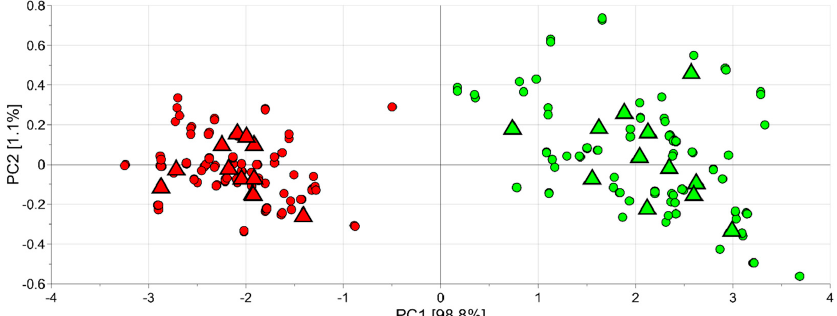
Figure 6. PCA model of the image data: circles represent the observations (technical replicates), while triangles indicate the medians of the technical replicates of the same sample; green is used for observations belonging to the half-red group and red for those of the red group. The relationships between image data and the chemical attributes (TA, TP, AA and TSS) were explored by heatmap (Figure 7). As in the case of ATR-FTIR data, two clusters were discovered for the chemical data. Specifically, TA, TP and AA behave similarly being positively correlated to the colour parameters, while TSS showed an opposite trend, being negatively correlated to the colour parameters. On the other hand, the colour parameters were grouped into two clusters, one formed by Chroma and a* and the other including b*, L* and Hue-angle. Only TA resulted to be significantly correlated to the image data that mirrored its trend. The development of fruit colour during ripening is considered a maturity index and when its intensity increases, the ripening attributes also improve. As the fruit colour development enhances, the TSS content increases proportionately. On the contrary, the trend of the fruit acidity decreases with the enhancement of the colour of fruit during ripening [30]. This result suggests that the prediction of TA by the colour parameters obtained by IA of the strawberry represent a valid method to rapidly assess the ripening stage.